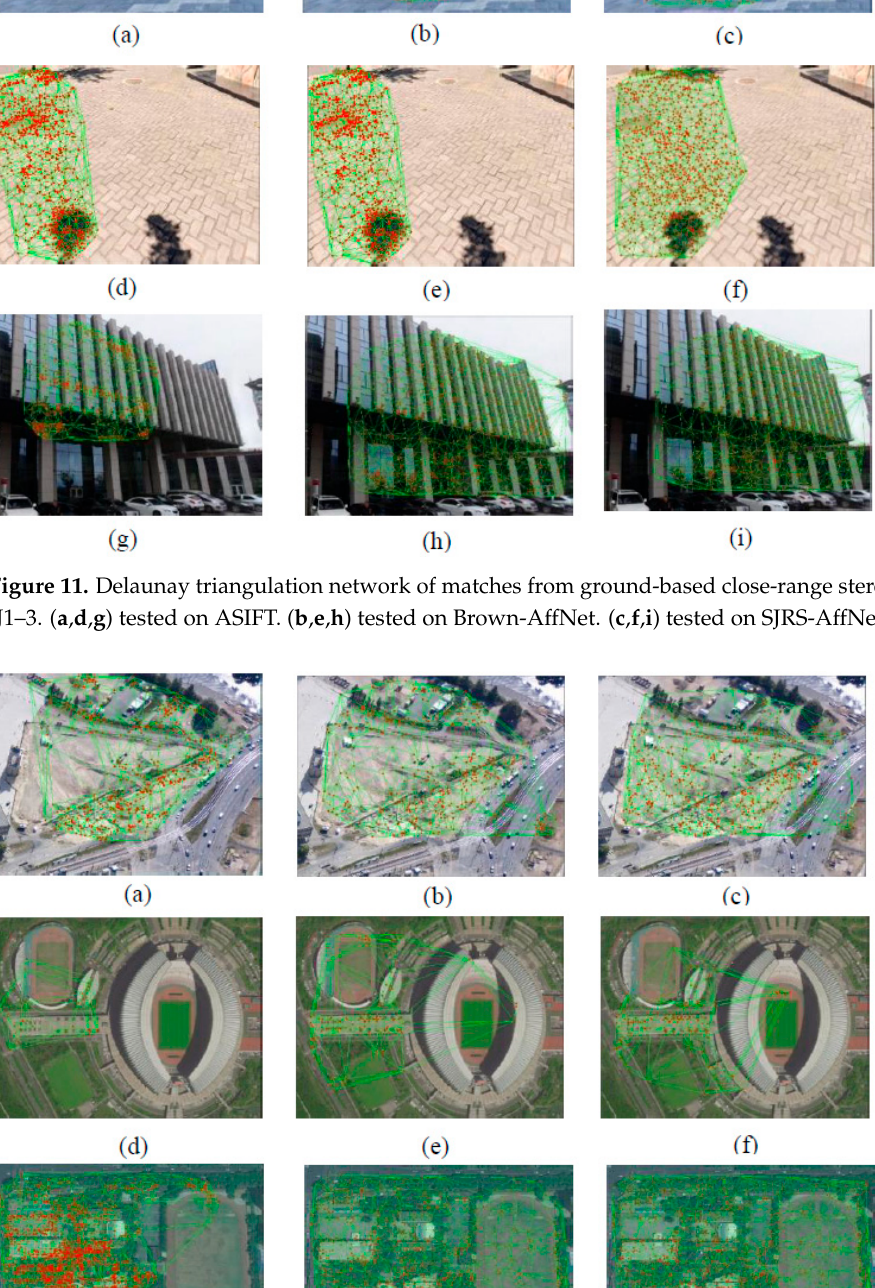
Figure 12. Delaunay triangulation network of matches from aerial stereo images HK1–3. ( a , d , g ) tested on ASIFT. ( b , e , h ) tested on Brown-AffNet. ( c , f , i ) tested on SJRS-AffNet.